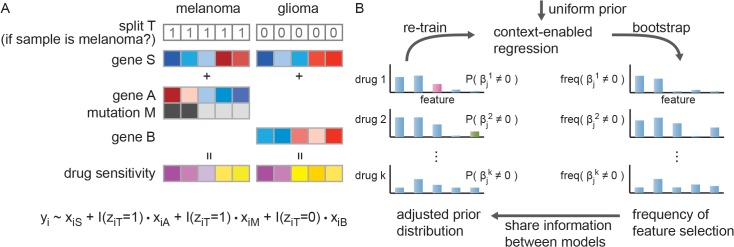
Overview of CHER algorithm.A. Example of a model learned by CHER, where the drug sensitivity of melanoma samples can be predicted by mutation of M and gene expression of A and S, whereas in glioma, expression of gene S and B are the predictors. CHER takes advantage of pooling samples together to gain statistical power, identifying both shared (gene S) and context-specific features (A, B and M). In cases where the relevant context is unknown, the algorithm searches for the best “split”, if any, to separate samples into two groups. Yi represents drug sensitivity of the ith sample, xi are the corresponding features of the ith sample, zit = 1 presents the ith sample is melanoma, and I(.) is an indicator function. B. Iterative learning scheme of CHER. CHER initially learns models with uniform prior (meaning each genomic feature has the same probability of being included in the model). During each iteration, CHER trains the regression models with bootstrapping, which allows the algorithm to establish the frequency of each feature being selected. Then CHER adjusts the priors according to the distribution of frequency and the similarity between phenotypes.